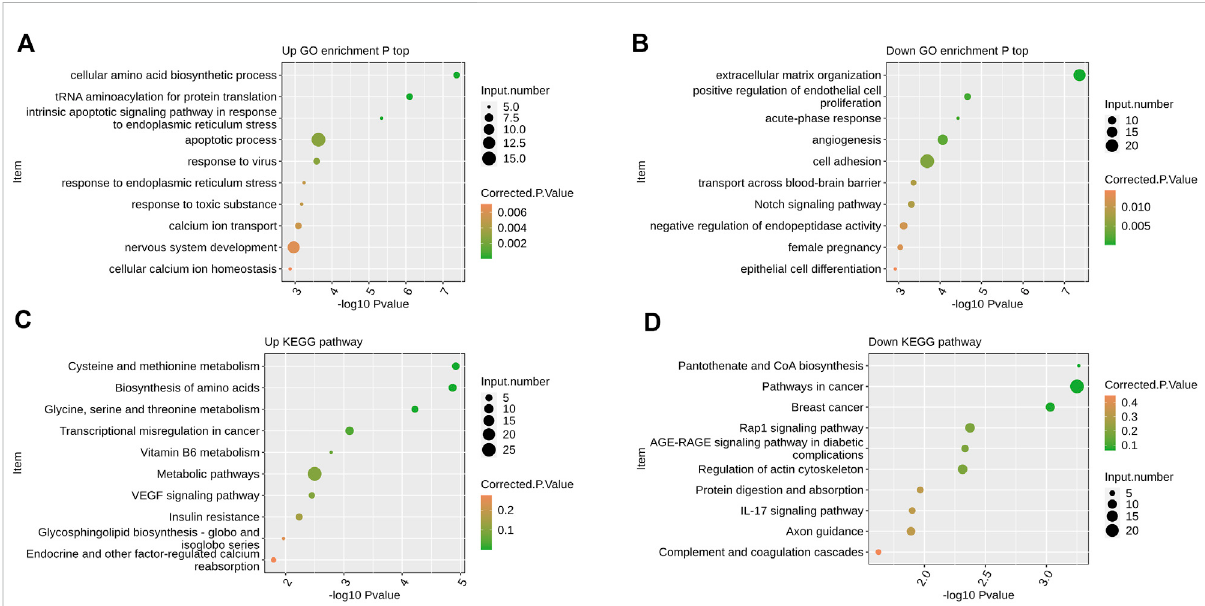
FIGURE 2 The effect of overexpression of PPM1K gene on the transcriptome of HK-2 cells (A) Scatter plot exhibiting the most enriched GO biological process results of the up-regulated DEGs (B) Scatter plot exhibiting the most enriched GO biological process results of the down-regulated DEGs. (C) Scatter plot exhibiting the most enriched KEGG pathway results of the up-regulated DEGs. (D) Scatter plot exhibiting the most enriched KEGG pathway results of the down-regulated